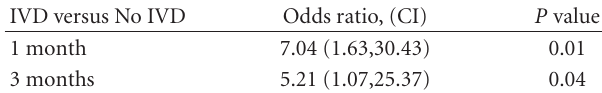
Table 4: Predictive factor ≥ 3 lines